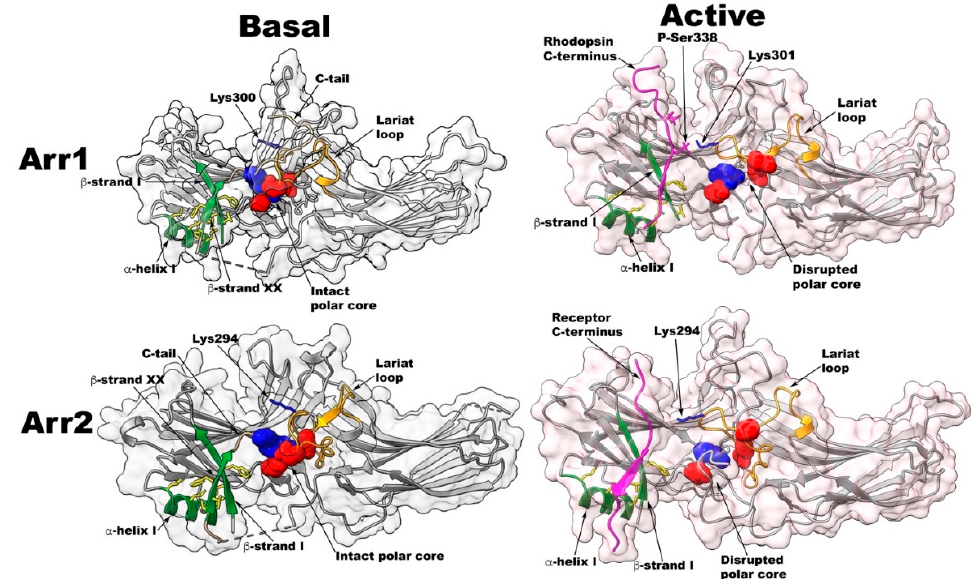
Figure 2. Receptor binding-induced conformational changes in arrestins. Top left. Basal structure of bovine arrestin-1 (PDB ID: 1CF4 [24]). Polar core residues are shown as CPK models (Asp30, Asp296, and Asp303 in red; Arg175 and Arg382 in blue). Lariat loop (containing Asp296, Lys300, and Asp303) is highlighted in yellow. Lys300 is shown as a blue stick model. In the three-element interaction, β -strand I and α -helix I of the N-domain and β -strand XX of the C-tail are shown in green, and bulky hydrophobic residues mediating the interaction are shown as yellow stick models. The part of the arrestin C-tail resolved in the structure is shown in light brown. Missing in structure connection between the C-domain and β -strand XX is shown as a dotted line. Top right. Structure of mouse arrestin-1 bound to human rhodopsin (PDB ID: 5W0P [6]). Note that because of an extra residue at the N-terminus, mouse residue numbers are greater than homologous bovine numbers by one. The C-terminus of bound rhodopsin is shown in magenta. Phosphate attached to rhodopsin Ser338 contacts lariat loop Lys301. Both the polar core and the three-element interaction are disrupted: in the polar core, Asp297 and Asp304 move away from Arg176 and Asp31, Arg residue supplied by the C-tail is absent; in the three-element interaction, β -strand XX of the C-tail is absent. Arrestin elements are shown, as in the top left panel. Lower left. Basal structure of bovine arrestin-2 (PDB ID: 1G4M [25]). Polar core residues are shown as CPK models (Asp26, Asp290, and Asp297 in red; Arg169 and Arg393 in blue). Lariat loop (containing Asp290, Lys294, and Asp297) is shown in yellow. Lys294 is shown as a blue stick model. In the three-element interaction, β -strand I and α -helix I of the N-domain and β -strand XX of the C-tail are shown in green, and bulky hydrophobic residues mediating the interaction are shown as yellow stick models. The part of the arrestin C-tail resolved in the structure is shown in light brown. Missing in the structure connection between the C-domain and β -strand XX is shown as a dotted line. Lower right. Structure of rat cysteine-less arrestin-2-(1–393) bound to human M2 containing the phosphorylated C-terminus of the vasopressin V2 receptor (PDB ID: 6U1N [8]). Residue numbers in rat and bovine arrestin-2 are the same. The V2 C-terminus of the bound receptor is shown in magenta. Attached phosphates were not resolved, but Lys294 points towards the receptor C-terminus. Both the polar core and three-element interaction are disrupted: in the polar core, Asp297 and Asp304 move away from Arg176 and Asp31, Arg residue supplied by the C-tail is absent; in the three-element interaction, β -strand XX of the C-tail is absent. Arrestin elements are shown, as in top left panel. Arr1—arrestin-1, Arr2—arrestin-2. The structures of receptor-bound arrestins have a pinkish